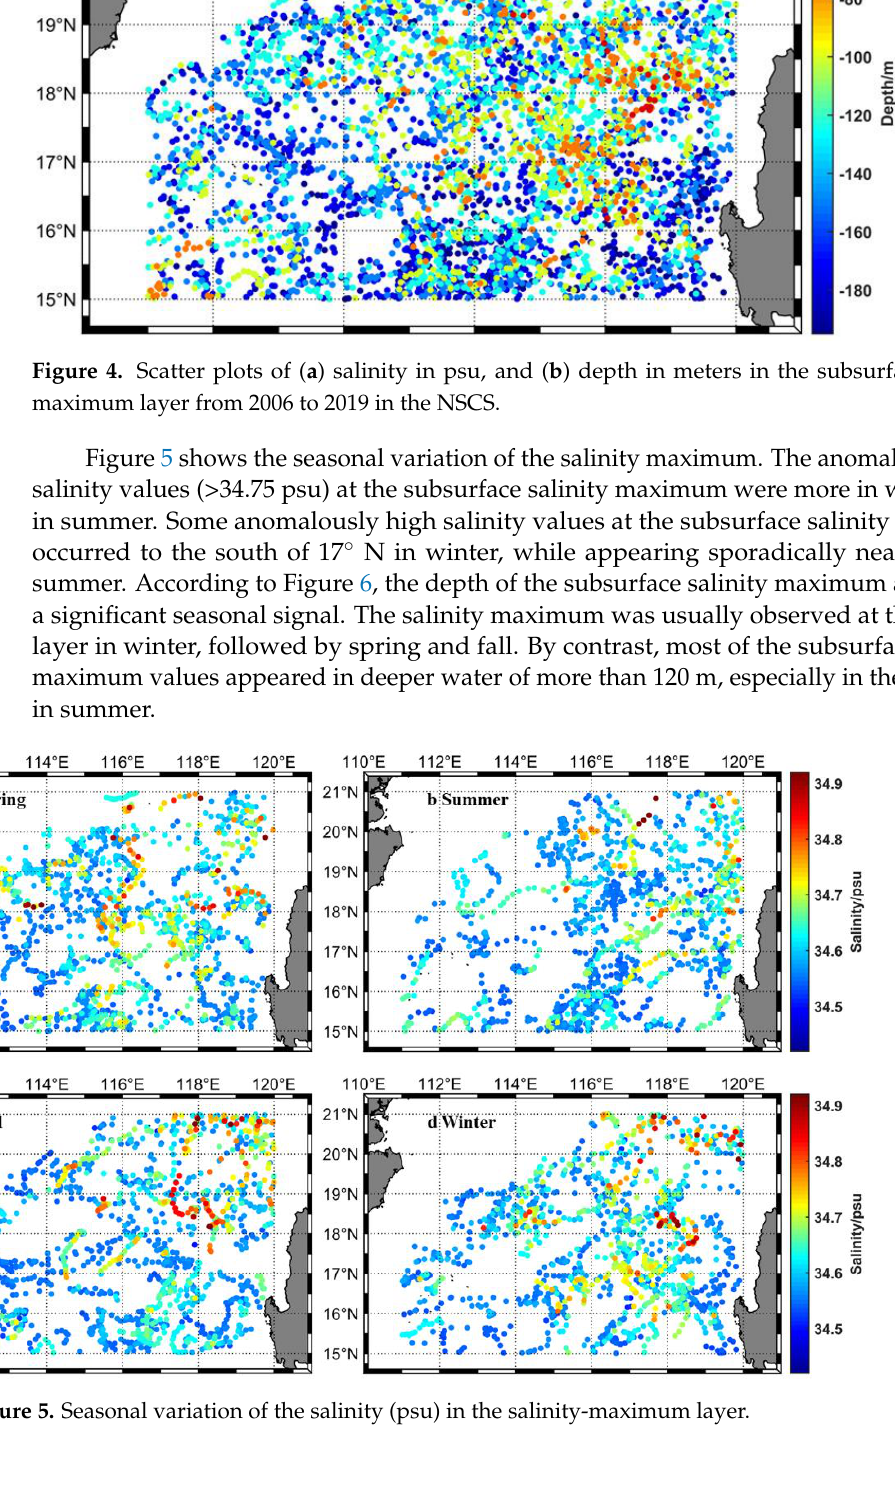
Figure 6. Seasonal variation of the depth (meters) in the salinity-maximum layer. 3.2. Anomalously High Subsurface Salinity The results as mentioned above show that anomalously high salinity at the subsur- face salinity maximum (salinity > 34.65 psu, H-Smax) frequently occurred in the NSCS, especially the area near the Luzon Strait. Therefore, it is of scientific and practical value to investigate the sources and distribution characteristics of the anomalously high salinity at the subsurface salinity maximum. The NSCS waters above the intermediate layer contain four well-defined water masses (T-S diagram in Figure 7a): the North Pacific Tropical Wa- ter (NPTW), low-salinity North Pacific Intermediate Water (NPIW), North Pacific Surface Water (NPSW) and NSCS Warm Water (NSCSWW). In Figure 7a, all the red dots (salinity